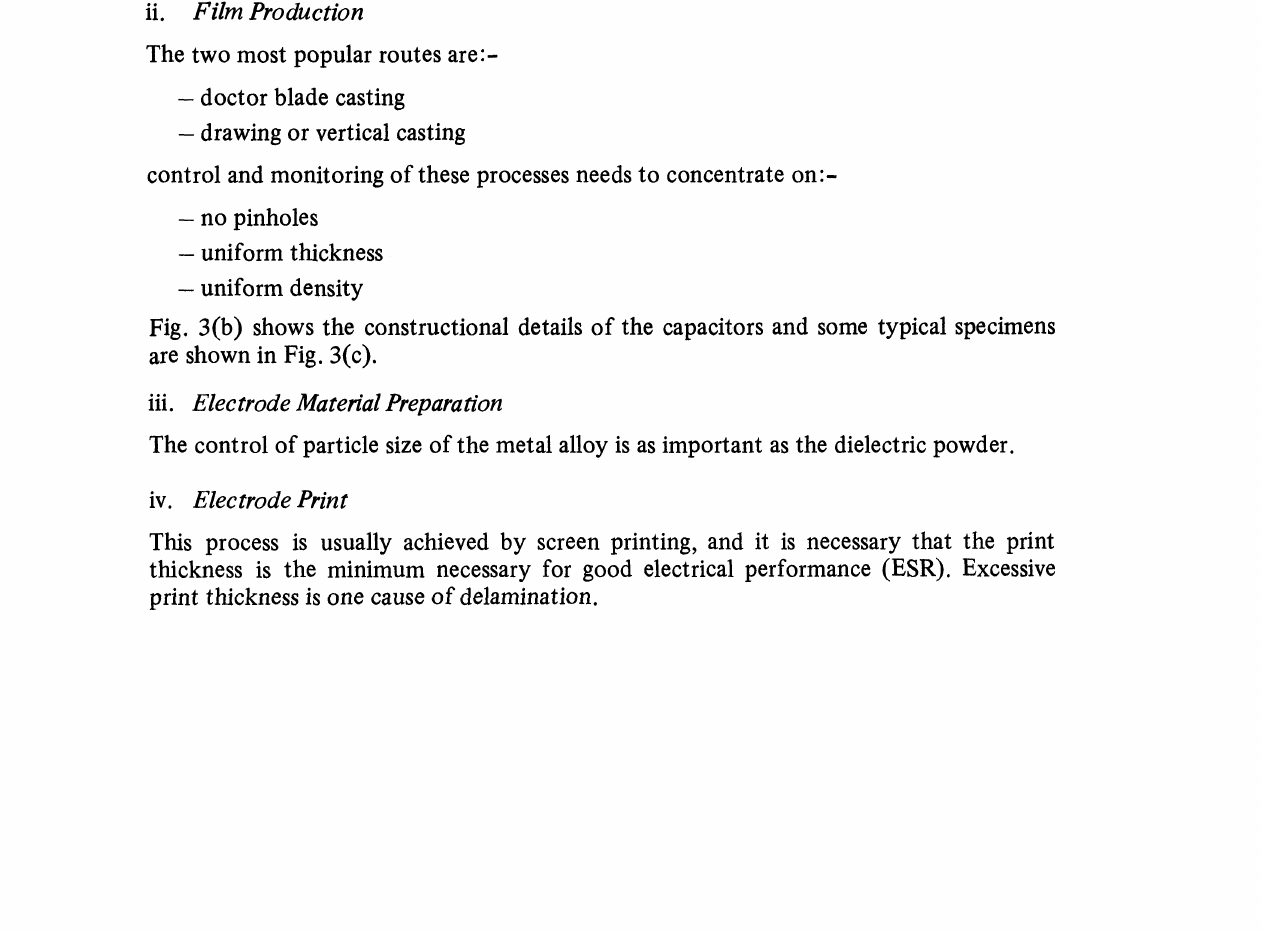
FIGURE 2 Memory board